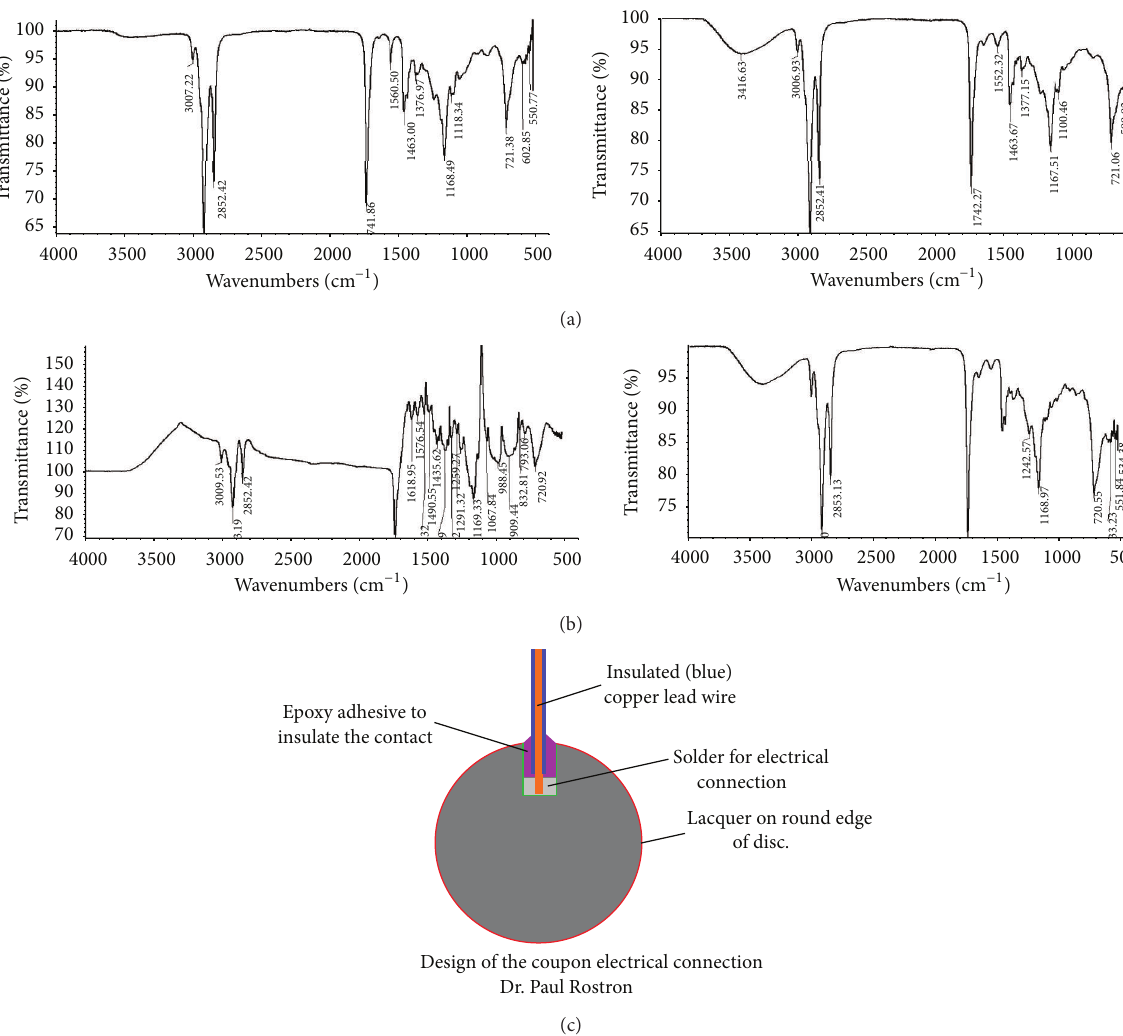
Figure 1: (a) FTIR spectra of the samples of Cress oil methyl ester and amide taken during the reaction. (b) FTIR spectra of the samples of Linseed oil methyl ester and amide taken during the reaction. (c) Design of the coupon electrical